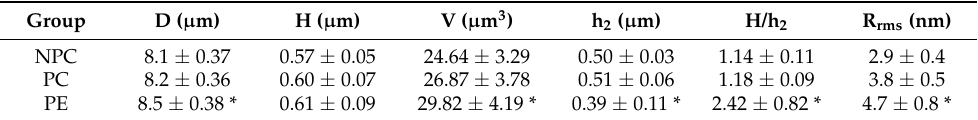
Table 3. Morphometric parameters: diameter (D), maximum height (H), volume (V), concavity depth (h 2 ), ratio of the maximum height and concavity depth (H/h 2 ), and roughness (R rms ) of freshly isolated RBCs from non-pregnant controls (NPCs) and pregnant controls (PCs), and patients with preeclampsia (PE). R rms values were evaluated from AFM images of a 2 × 2 µ m 2 area. Group D ( µ m) H ( µ m) V ( µ m 3 ) h 2 ( µ m) H/h 2 R rms (nm) NPC 8.1 ± 0.37 8.2 ± 0.36 * Indicates statistical difference at the level of p < 0.05, relative to both NPCs and